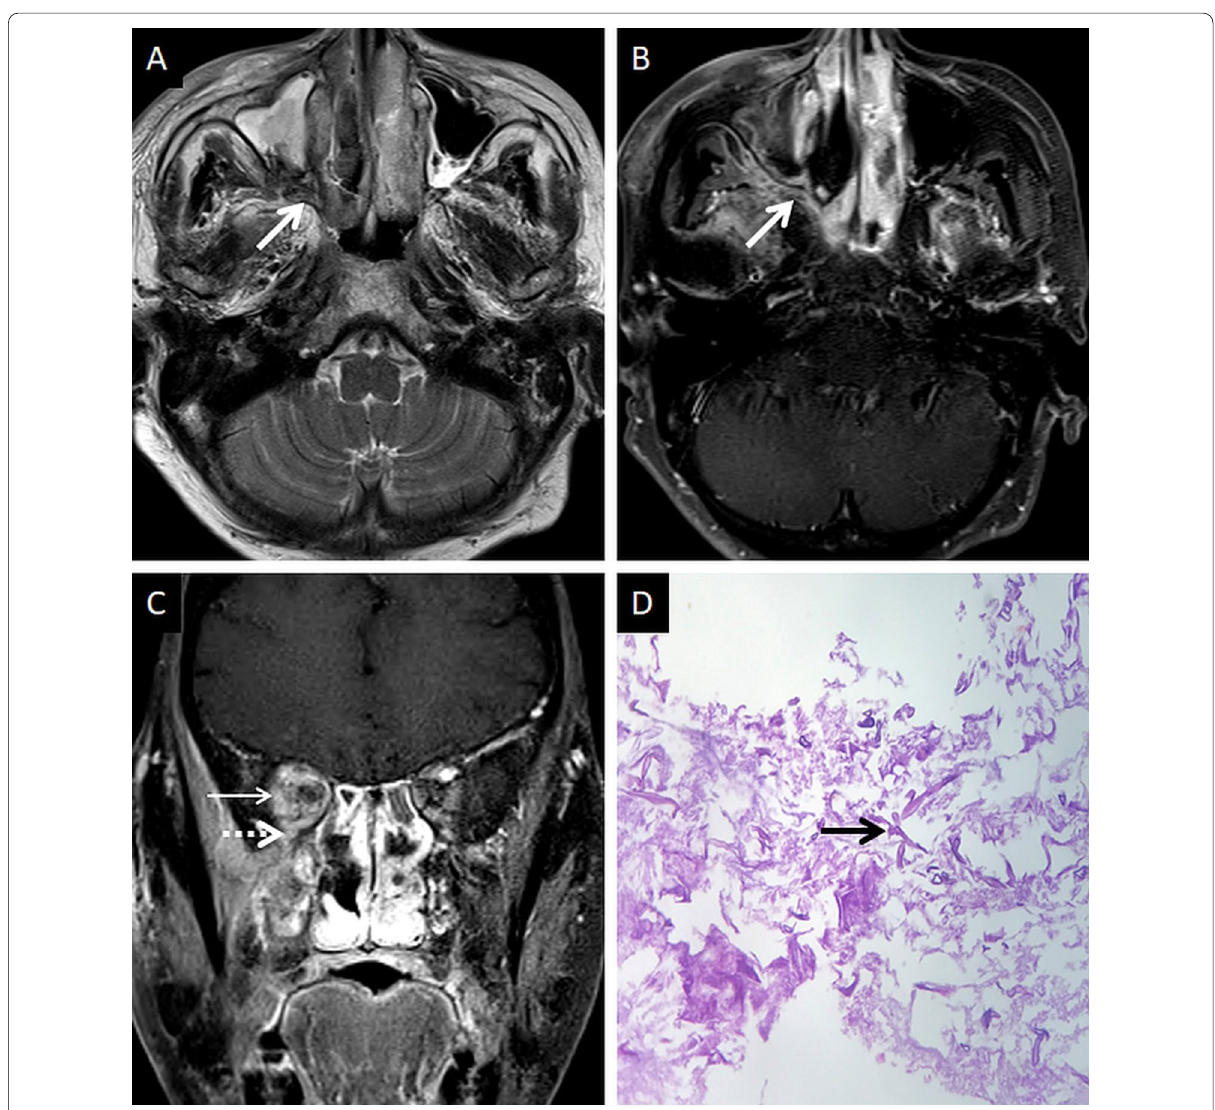
Fig. 10 PPF involvement with orbital spread of ROCM. Axial T2W image of the brain ( a ) reveals hypointense soft tissue within the right PPF (thick arrow). CE FS axial T1W image ( b ) demonstrates heterogeneous enhancement of the soft tissue (thick arrow). CE FS T1W image ( c ) reveals ipsilateral intraorbital extension (thin arrow) of the soft tissue, via the inferior orbital fissure (dotted arrow). Post-debridement histopathology analysis ( d ) confirms branching fungal hyphae (thick arrow) compatible with the diagnosis of